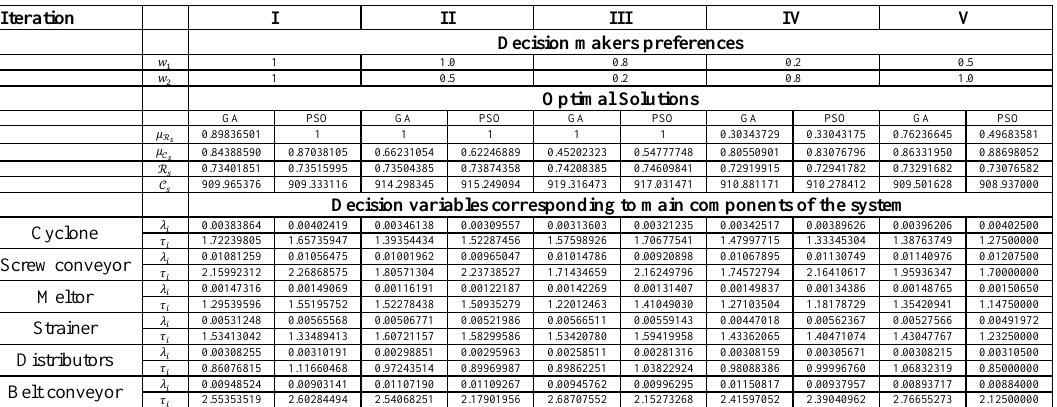
Table 3. Solution of the reliability optimization problem of prilling and carbon recovery